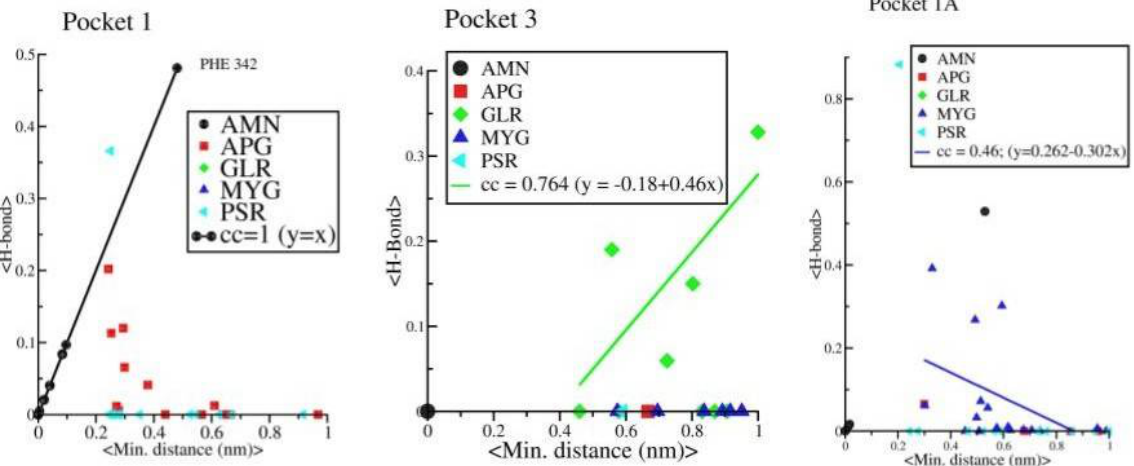
Figure 12. Correlation between average minimum distance between amino acid residues of the protein and ligand vs. the average HB distance between amino acid residues of the protein and ligand.